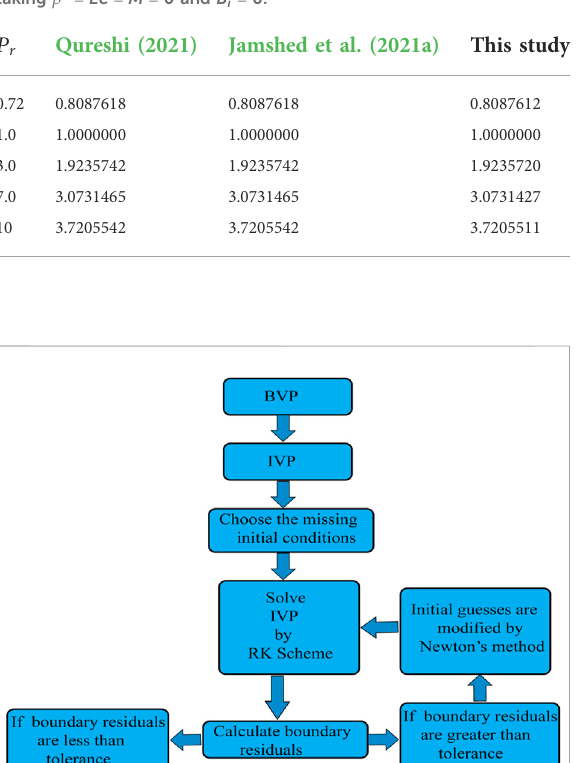
FIGURE 2 Flow sheet of shooting